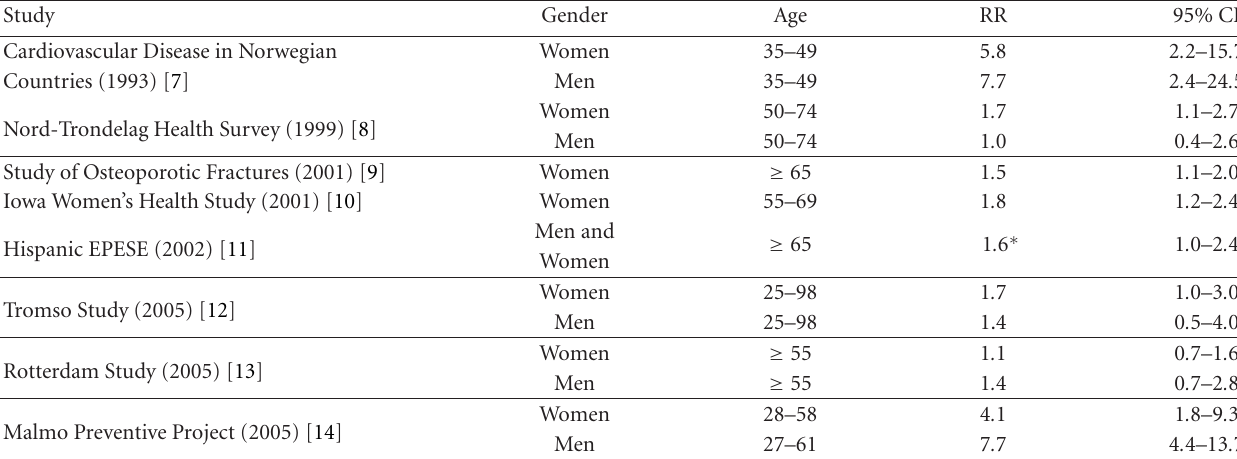
Table 1: Age-adjusted relative risk of hip fracture for older adults with type 2 diabetes.